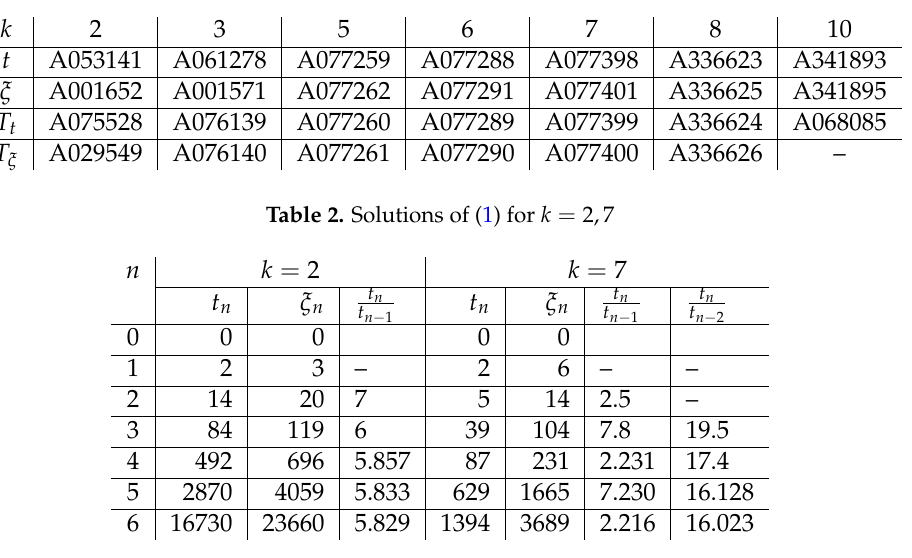
Table 1. OEIS [10] references of sequences of integer solutions of (1) for k = 2,3,5,6,7,8,10